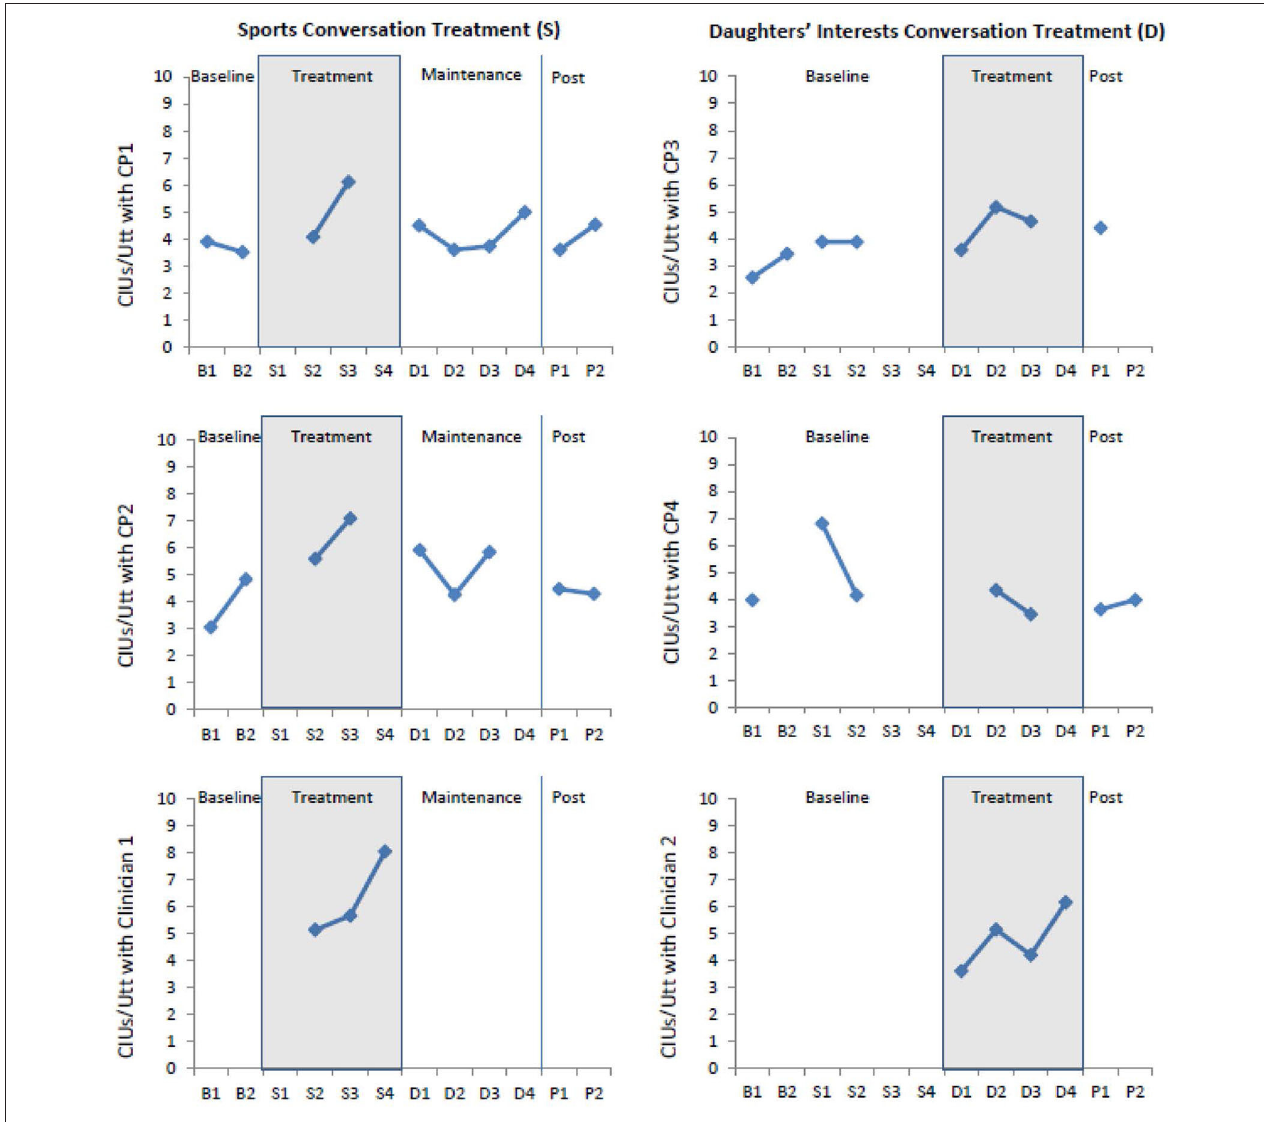
FIGURE 1 | CIU’s/utterance produced by BG during probes (top four graphs) and during treatment sessions (bottom two graphs) with six conversation partners (CP1, CP2, Clinician 1, CP3, CP4, and Clinician 2) during Sports and Daughters’ Interest conversations throughout baseline, treatment, and post-treatment phases. Missing data from probes (top four graphs) were due to missed appointments by designated conversational partners. To supplement this missing information information, data from conversations with clinicians during treatment session (bottom two graphs) are also included.